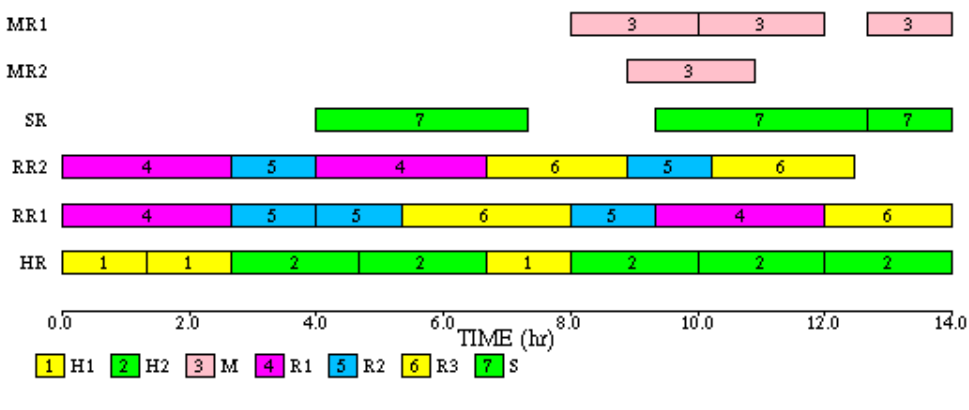
Figure 13. Example 5 Gantt chart.